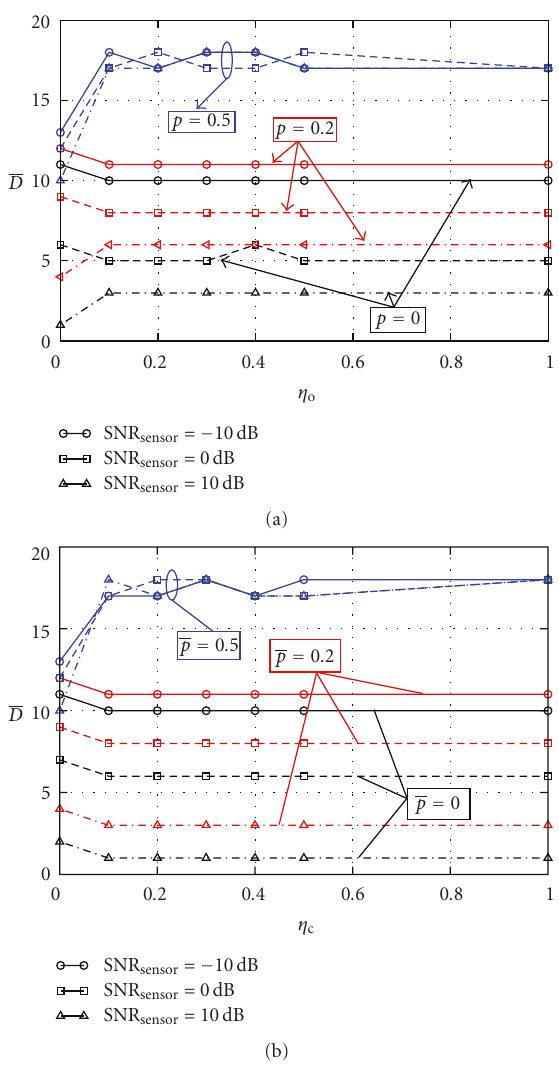
Figure 9: Distance, as a function of (a) η o and (b) η c , in the presence of mismatches in the (a) observation phase and (b) communication phases, respectively. In all cases, we consider N = 8 sensors, binary quantization at the sensors, and simplified detection rule at the AP. Various combinations of the values of p (in case (a)), p (in case (b)), and the sensor SNR are